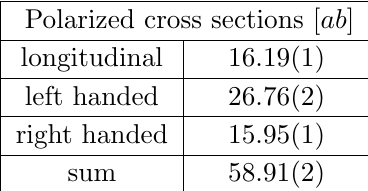
Table 12 . Polarized cross sections ( ab ) for the VBS ZZ production in the presence of lepton